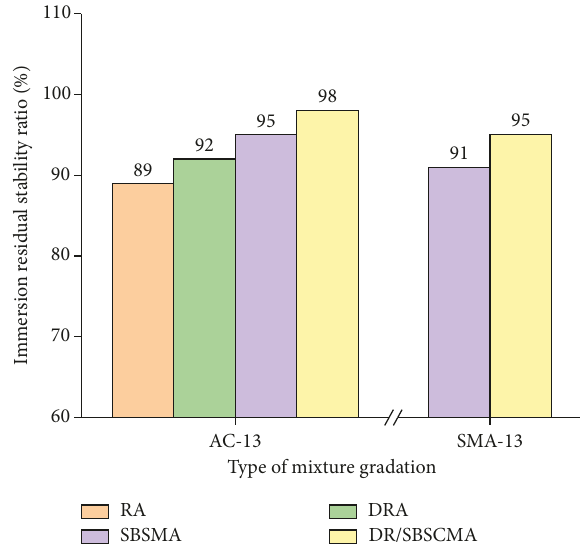
Figure 15: Marshall test results of mixture immersion in water.